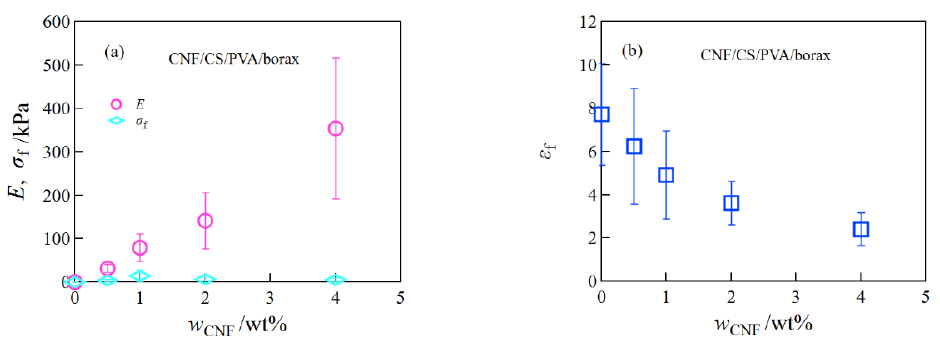
Figure 4. The Young’s modulus and the fracture stress ( a ) and the fracture strain ( b ) of CNF/CS/PVA hydrogels at different CNF concentrations.